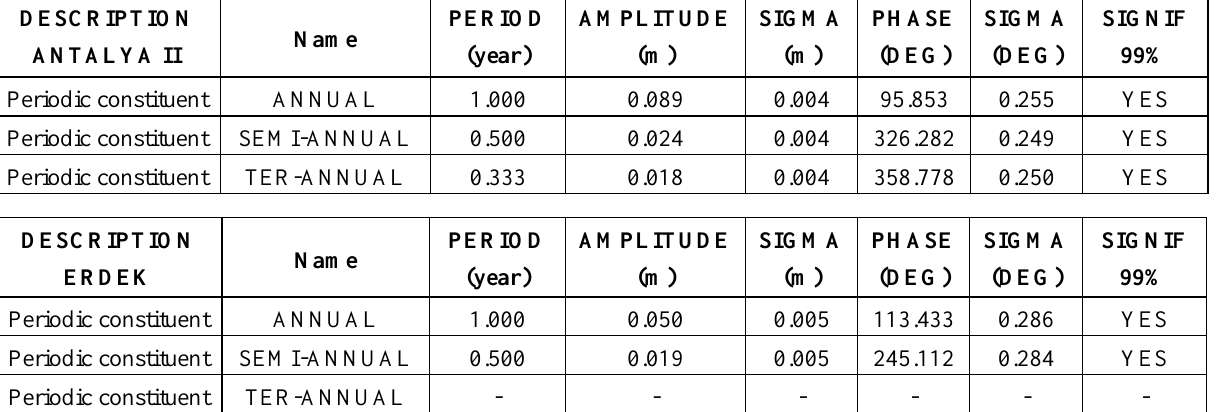
Table 2. The LSSA results of the sea-level data of Antalya-II and Erdek tide gauges.